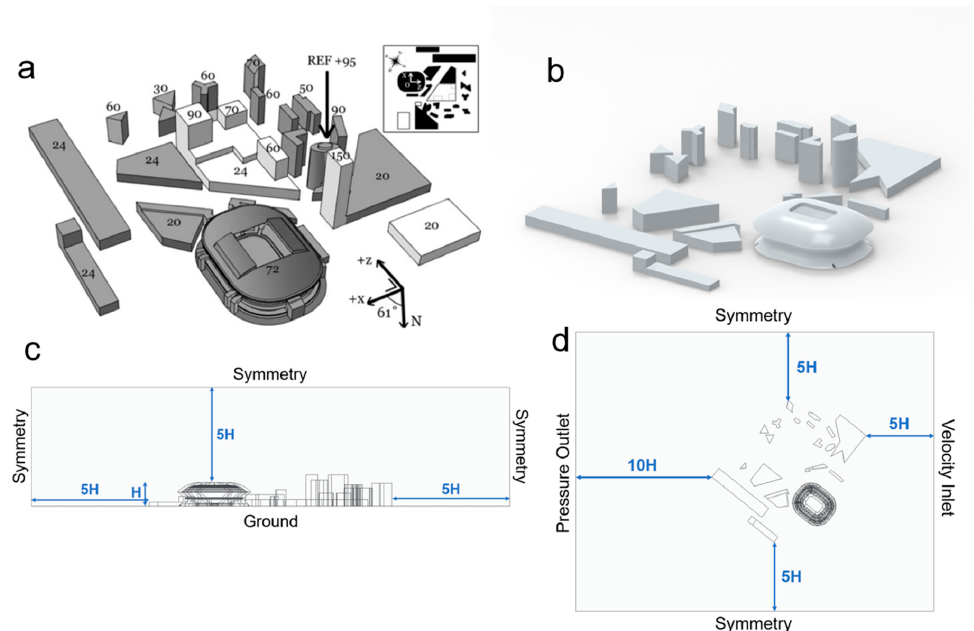
Figure 1. ( a ) The Johan Cruyff Arena and its surrounding buildings situated in a radius of 300 m from the stadium from a previous work [30]. ( b ) Geometry model of the stadium and its surrounding buildings used in the present study. ( c ) Extension dimensions and boundary conditions of the computational domain (section view). ( d ) Extension dimensions and boundary conditions of the computational domain (top view).